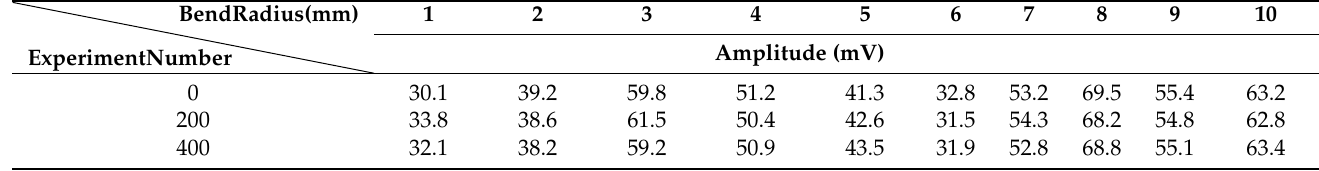
Figure 17. Spectrum Analysis Diagram: ( a ) Electromagnetic Noise Spectrum; ( b ) Spectrum of PD Signals Detected by Antennas with Different Bending Degrees. Table 3. PD signal